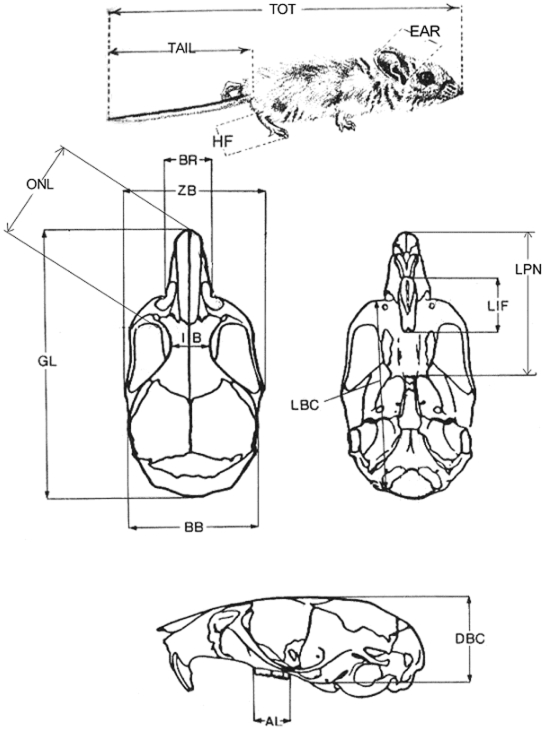
15 measurements used in this paper.Total length (TOT), tail length (TAIL), hind foot length (HF), ear length (EAR), alimentary toothrow (AL), breadth of braincase (BB), breadth of rostrum (BR), depth of braincase (DBC), greatest length of skull (GL), interorbital breadth (IB), length of braincase (LBC), length of incisive foramen (LIF), length of palate plus incisor (LPN, measured as the greatest distance from the end of the nasals to the mesopterygoid fossa), length from supraorbitals to nasals (ONL, measured as the least distance from the supraorbital notch to the tip of the nasals), and zygomatic breadth (ZB).